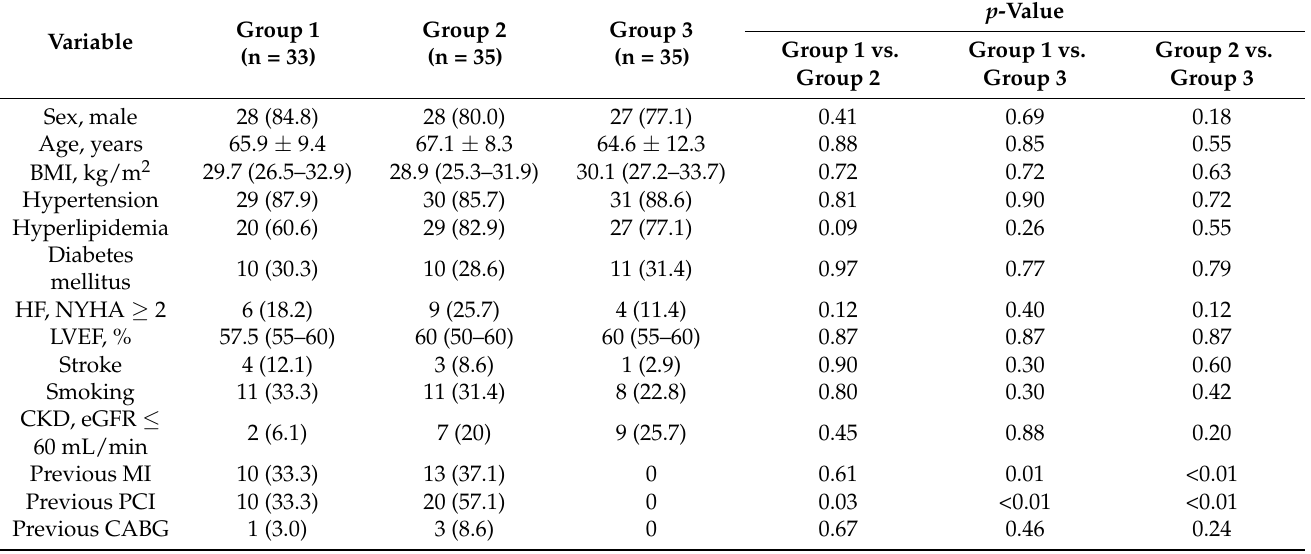
Table 1. Baseline clinical